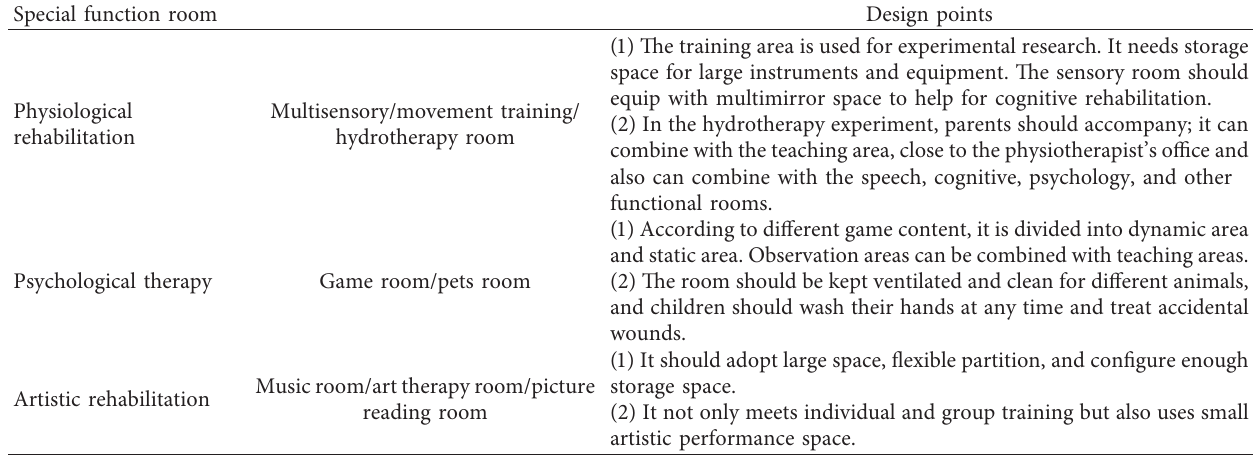
Table 6: Design essentials of special functional rooms